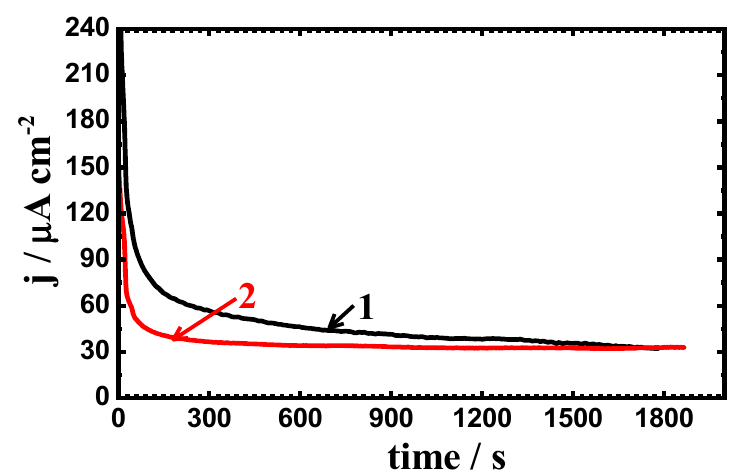
Figure 11. The obtained current vs. time curves at − 700 mV for ( 1 ) API-2H steel and ( 2 ) 75%Cr 3 C 2 − 25%NiCr coated API-2H steel after immersion in 4% NaCl solution for 1 h.